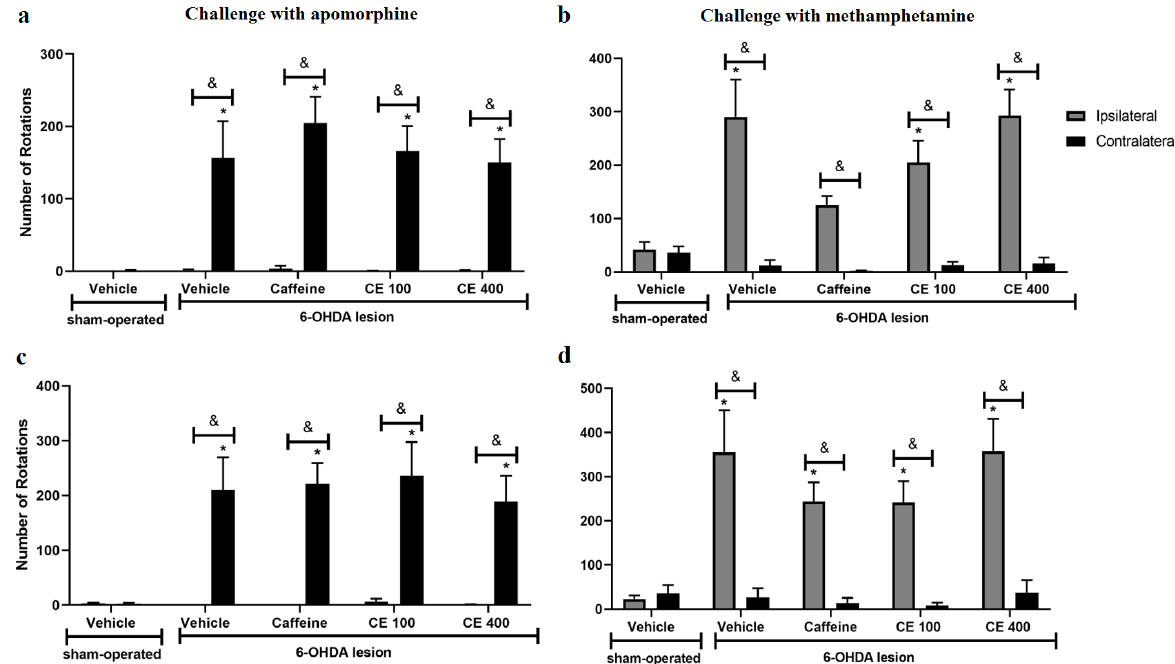
Figure 4. Repeated treatment with CE or caffeine do not affect the rotational behavior induced by apomorphine (0.1 mg/kg, sc) and methamphetamine (2.5 mg/kg, ip) in rats with 6-OHDA unilateral lesion of medial forebrain bundle (MFB). a) apomorphine challenge in the 15 th day. b) methamphetamine challenge in the 16 th day. c) apomorphine challenge in the 29 th day. d) methamphetamine challenge in the 30 rd day. Data are expressed as mean ± standard error of mean, n=12-15. * p <0.05 statistically different from sham-operated group (Kruskall- Wallis/Mann-Whitney). & p <0.05 statistically different when comparing ipsilateral vs contralateral (intra-group comparison,